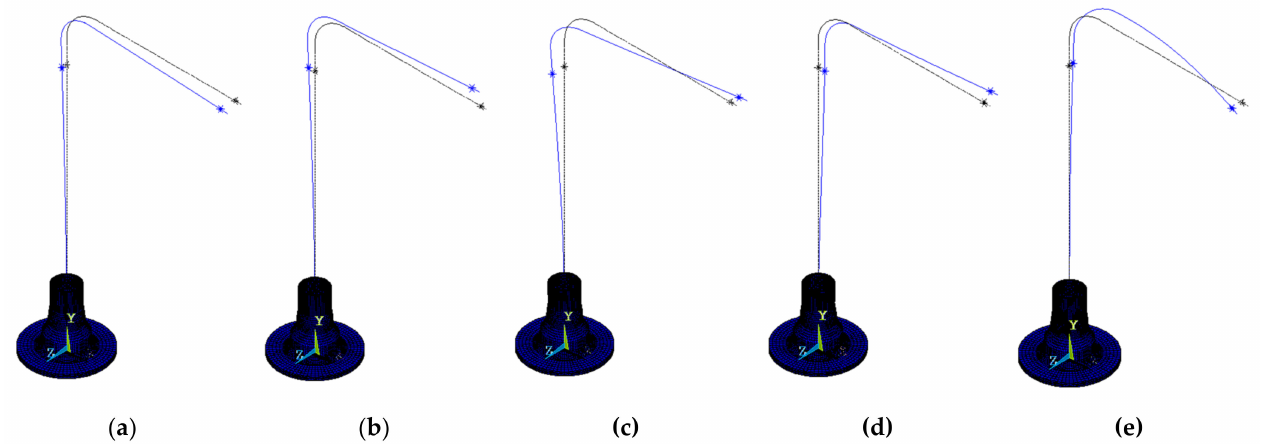
Figure 4. Mode shapes for test mockup: ( a ) Mode 1 (11.74 Hz); ( b ) Mode 2 (11.99 Hz); ( c ) Mode 3 (25.89 Hz); ( d ) Mode 4 (27.63 Hz); ( e ) Mode 5 (101.61